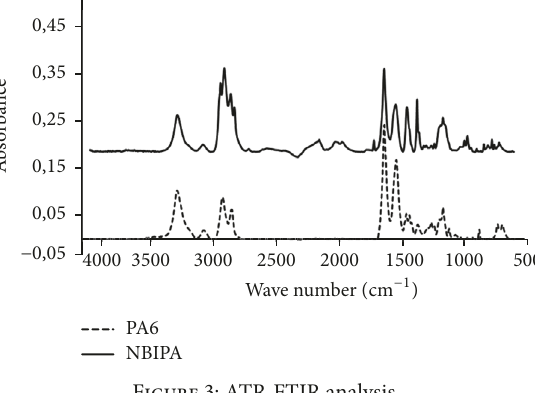
Figure 3: ATR-FTIR analysis.